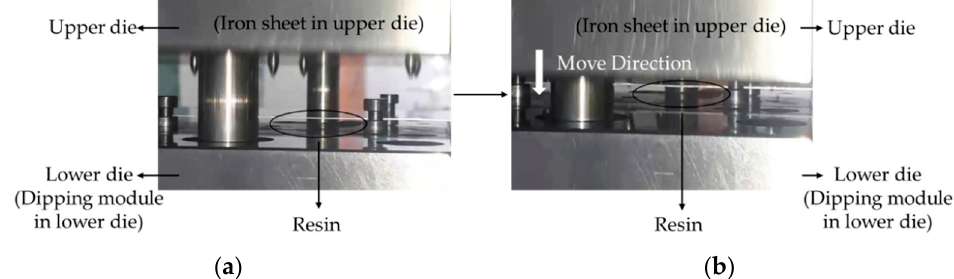
Figure 3. Motor core manufacturing process steps. ( a ) The position of the resin, upper die, and lower die and ( b ) the move direction of the upper die.